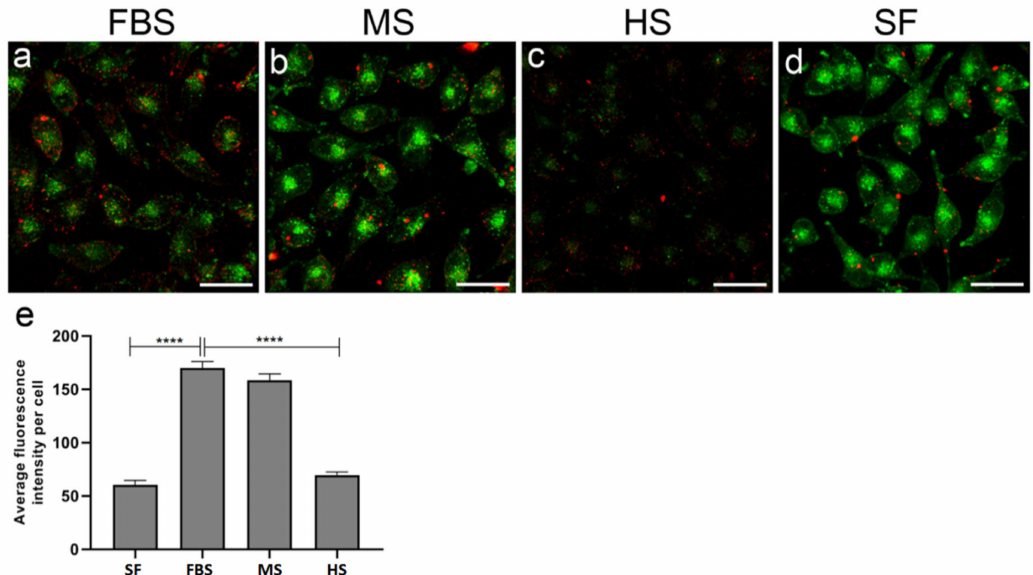
Figure 5. Association of PF14-SCO nanoparticles carrying different protein corona with cells. Complexes of PF14 with Cy5-SCO prepared at molar ratio 5, were incubated with HeLa cells in culture medium containing 10% of foetal bovine serum ( a ), murine serum ( b ), or human serum ( c ), or lacking serum ( d ) for 1 h. Lysosomes and other acidic organelles were visualised with Lysosensor Green. Localisation of nanoparticles based on Cy5 label on SCO (red), and acidic organelles (green) was captured in living cells with confocal microscope FV1000 and cell-associated SCO-Cy5 was quantified using Autoquant software ( e ). Scale bar 30 µ m. Representative images from three independent experiments are presented. In panel ( e ), bars represent average fluorescence intensity per cell ± SEM. Data was analysed using one-way ANOVA with post-hoc Tukey’s test. **** p <